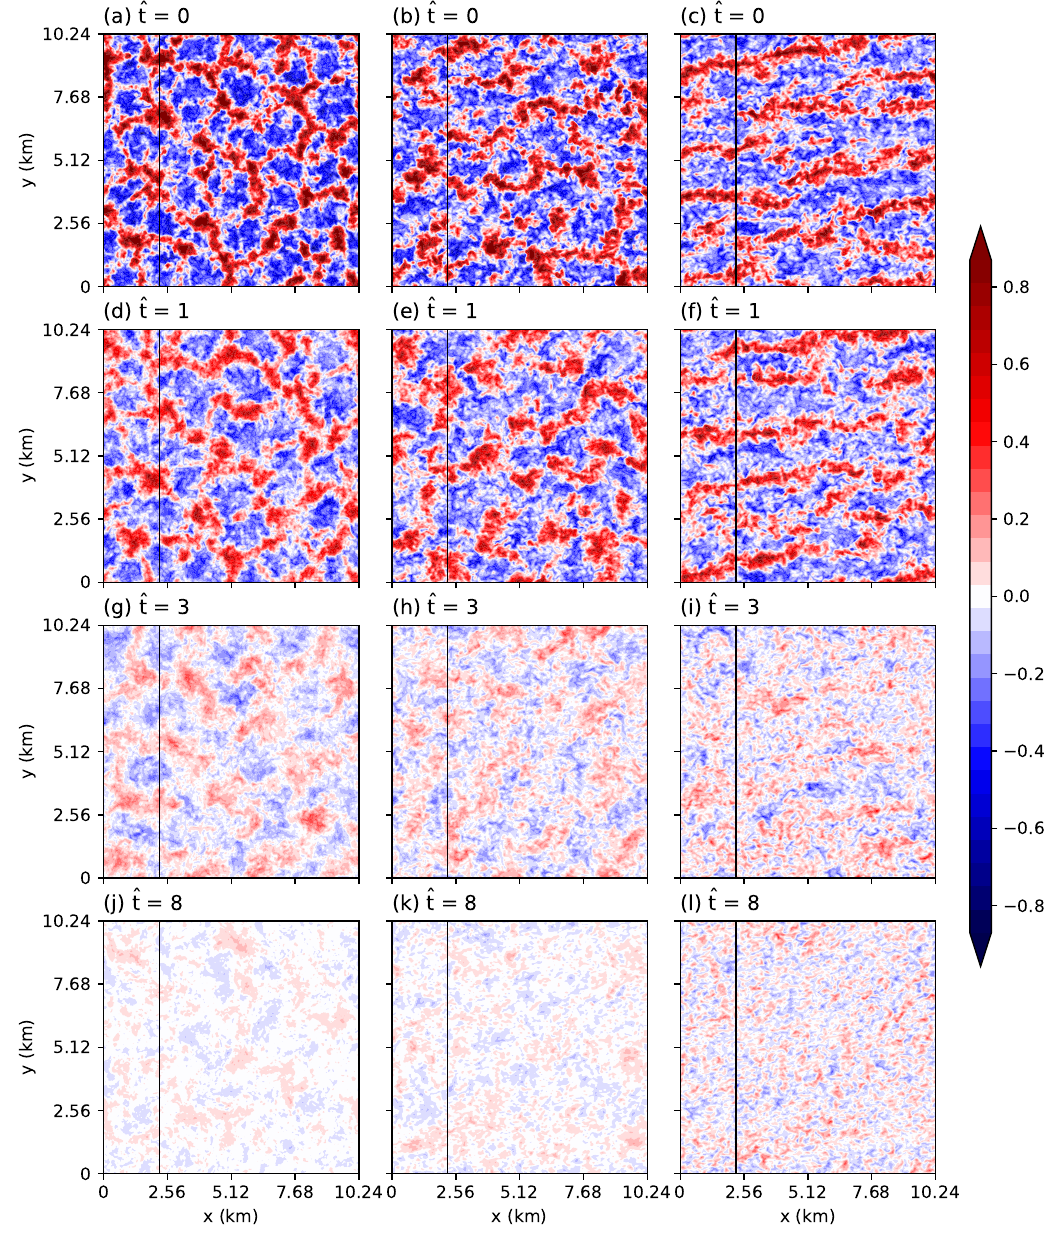
Figure 4. Fields of normalized and vertically averaged vertical velocity at ˆ t = 0 in the ( a ) B3, ( b ) I2, and ( c ) S1 cases, and the same fields at ˆ t = ( d–f ) 1, ( g–i ) 3, and ( j–l ) 8. The black lines indicate the position of the ˆ t - y plane in Figure